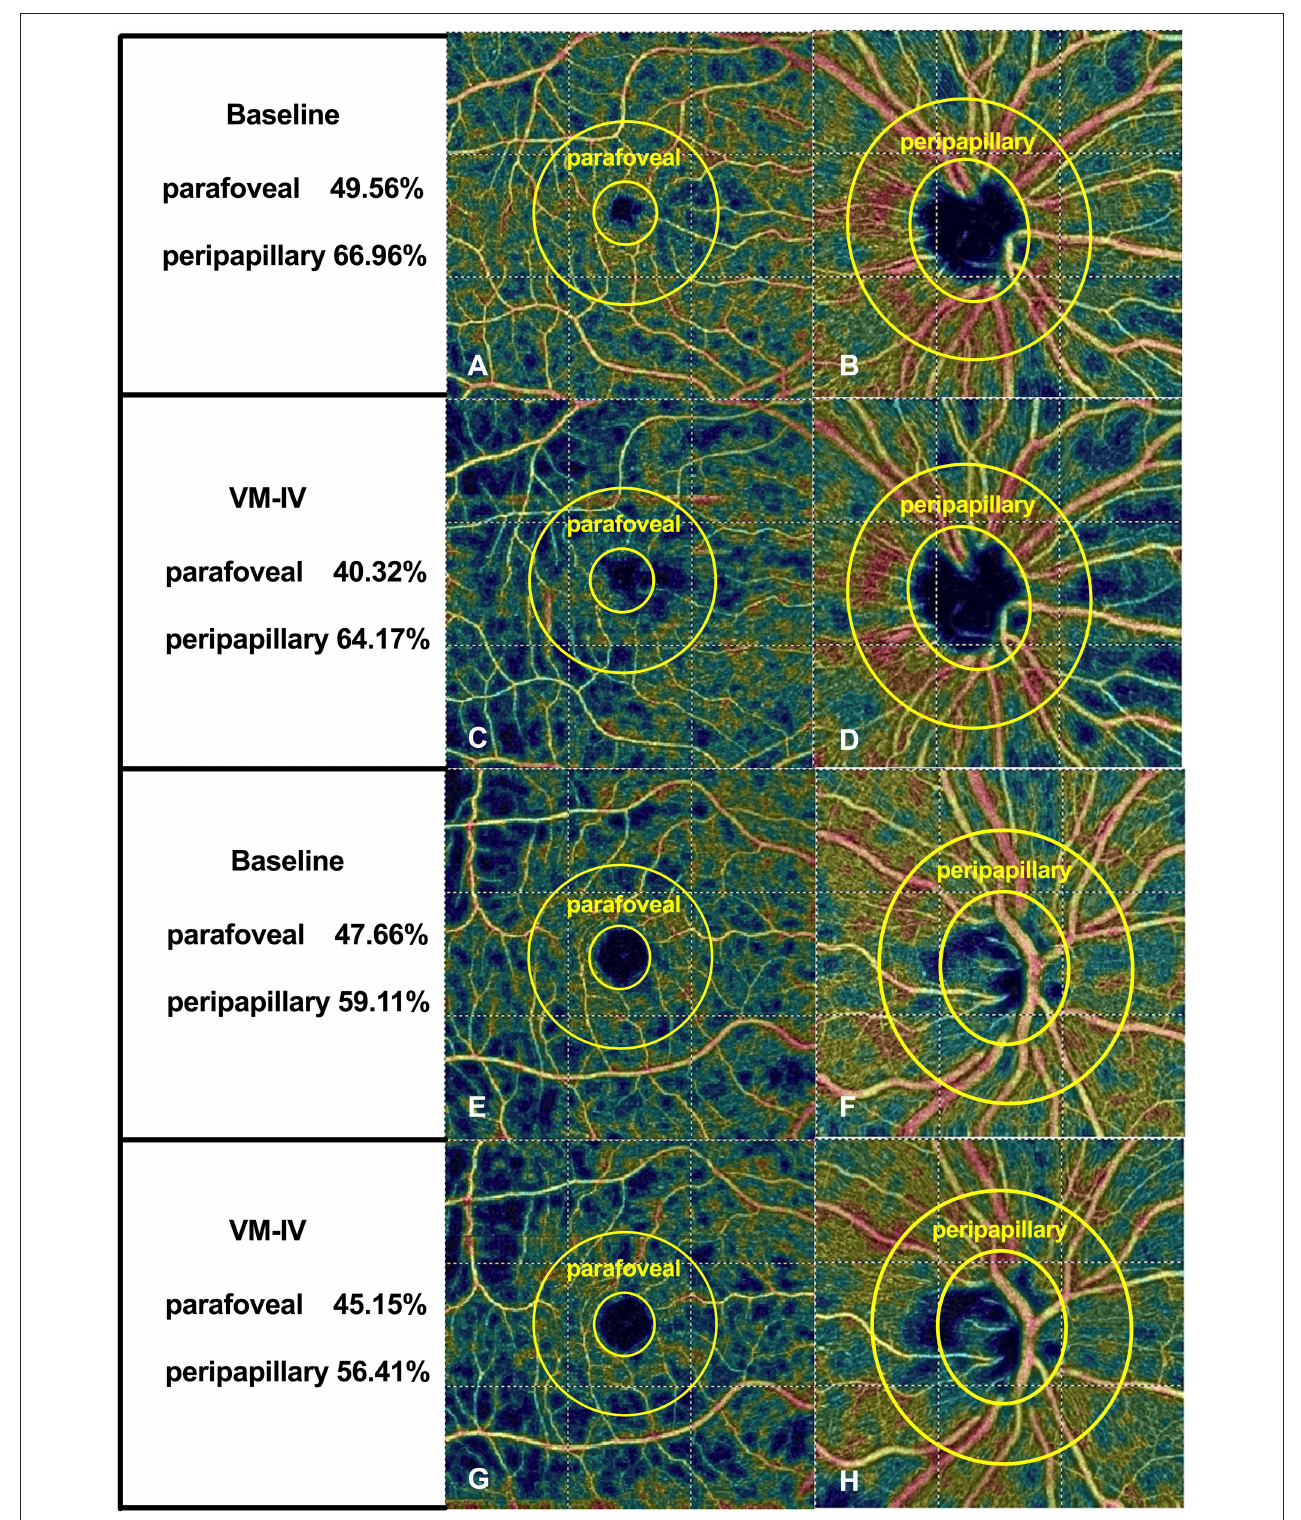
FIGURE 1 | Typical optical coherence tomography angiographic scanning images of non-smokers (A–D) and smokers (E–H) at baseline and during phase IV of the Valsalva maneuver.